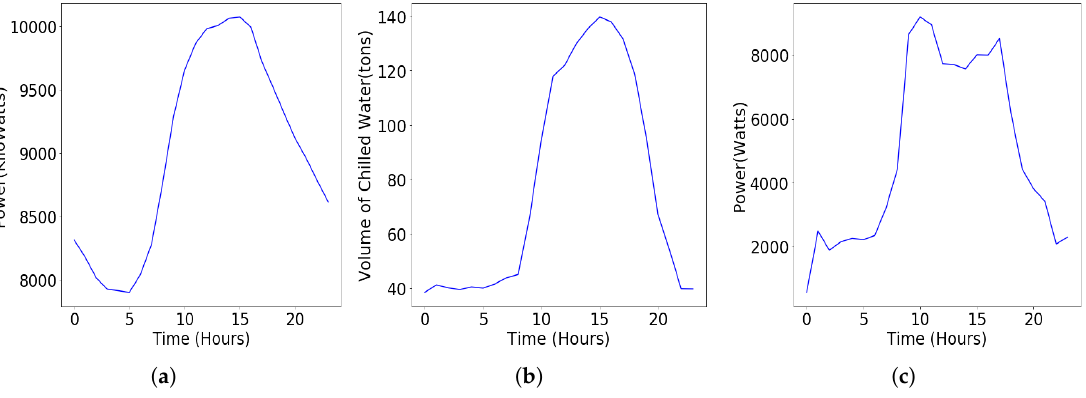
Figure 3. A Daily Load Profile for each of the dataset. ( a ) CMU electricity load; ( b ) Y2E2 cooling load; ( c ) Y2E2 lighting